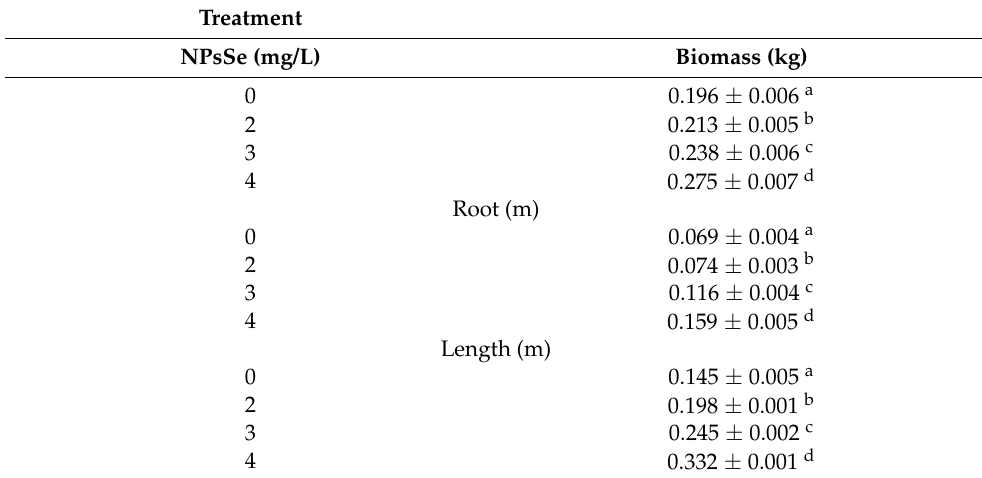
Table 1. Effect of foliar application of Se NPs on the agronomic and productive variables of the F. arundinacea Schreb. plants.